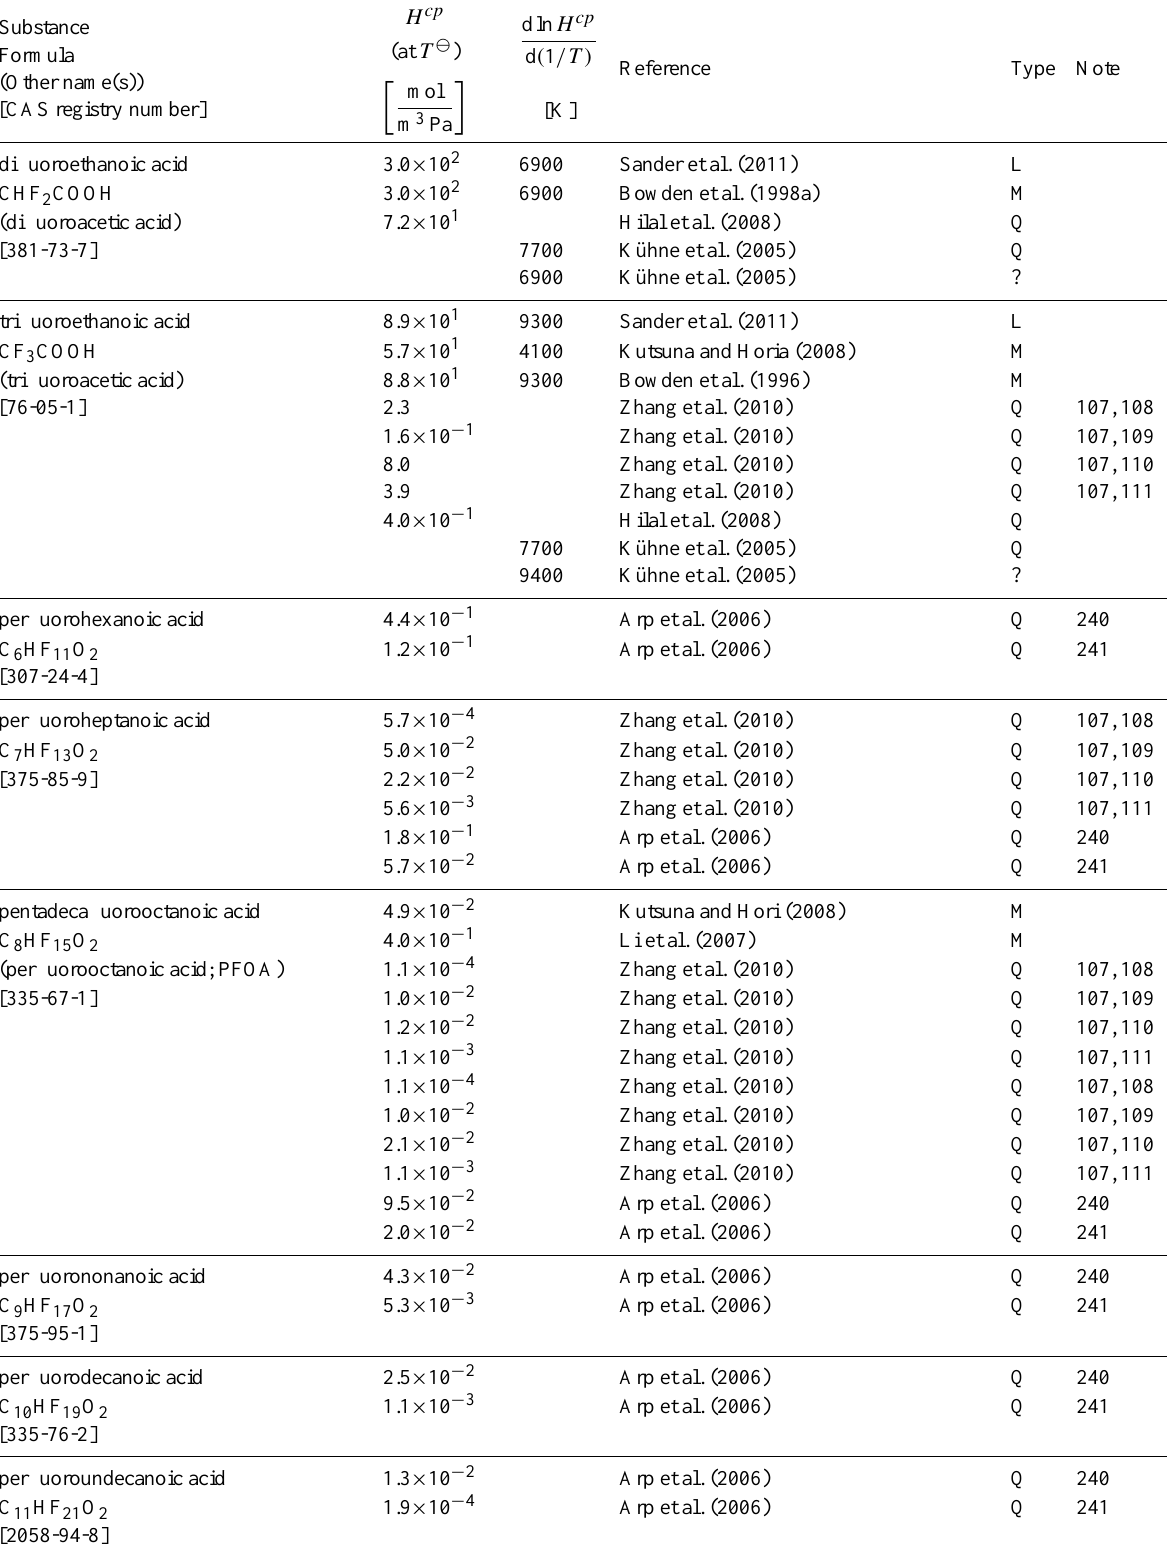
Table 6: Henry’s law constants for water as solvent